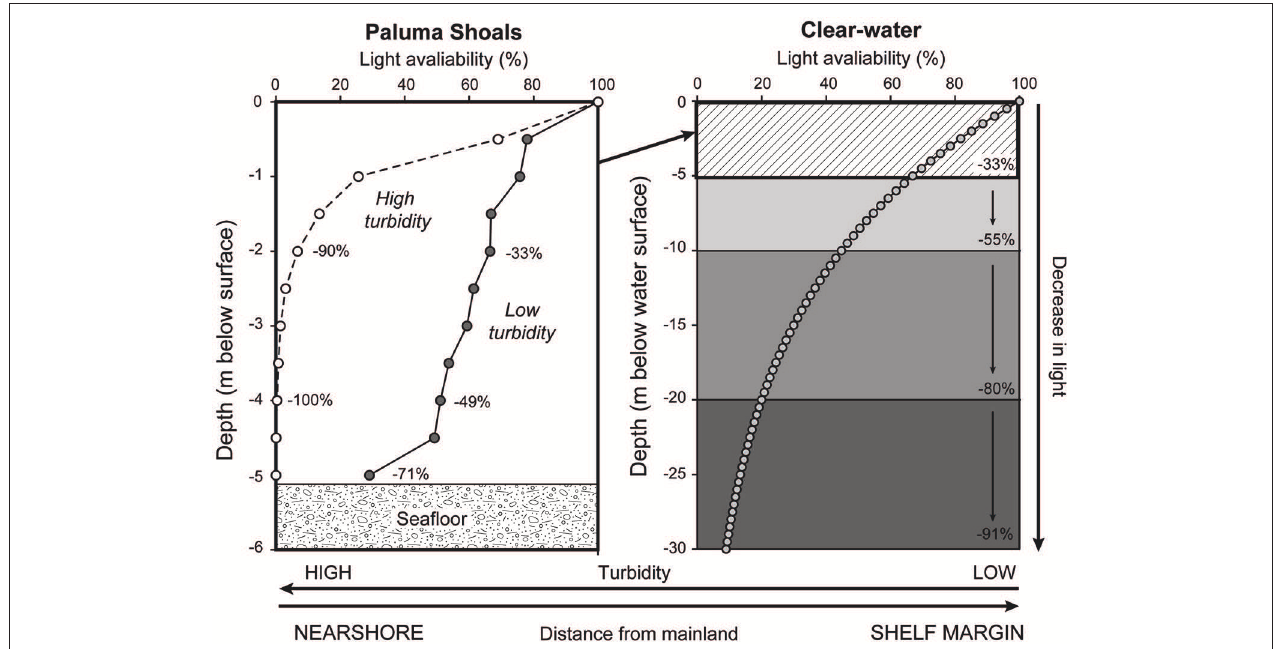
FIGURE 7 | Left-hand plot shows light attenuation data (% decay from the water surface) collected at Paluma Shoals reef complex at 0.5m depth intervals during low and high turbidity scenarios. Note the rapid reduction in light availability at 2m depth under high turbidity. Right-hand plot shows modeled light attenuation curve using equations generated for clear water (see Storlazzi et al.,